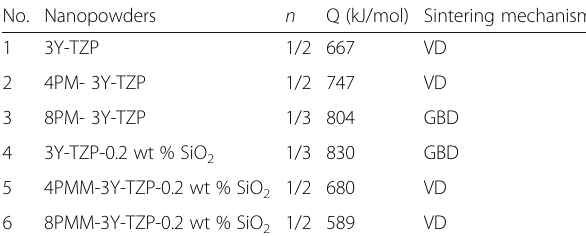
Table 3 Sintering mechanisms, parameters n and activation energies Q of investigated